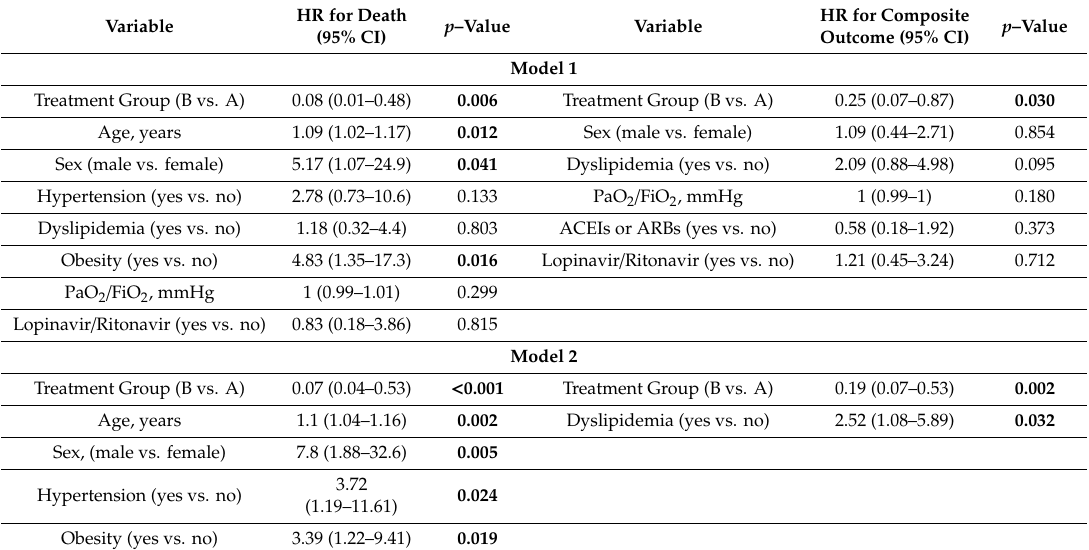
Table 3. Multivariate analysis for composite outcome and